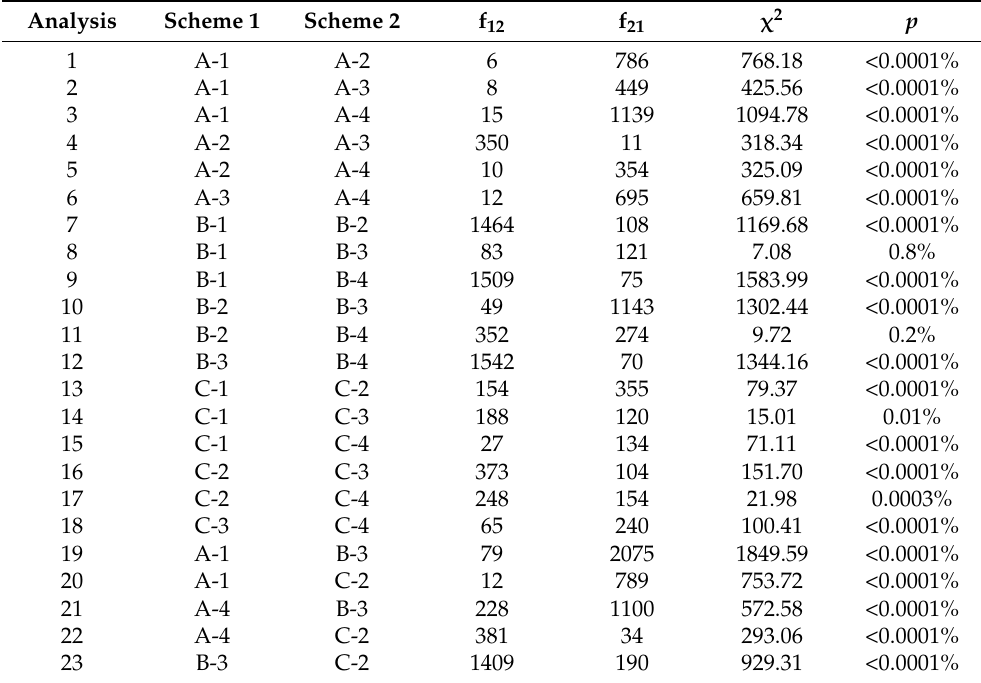
Table 10. Result of the McNemar’s test for different combination schemes of red edge